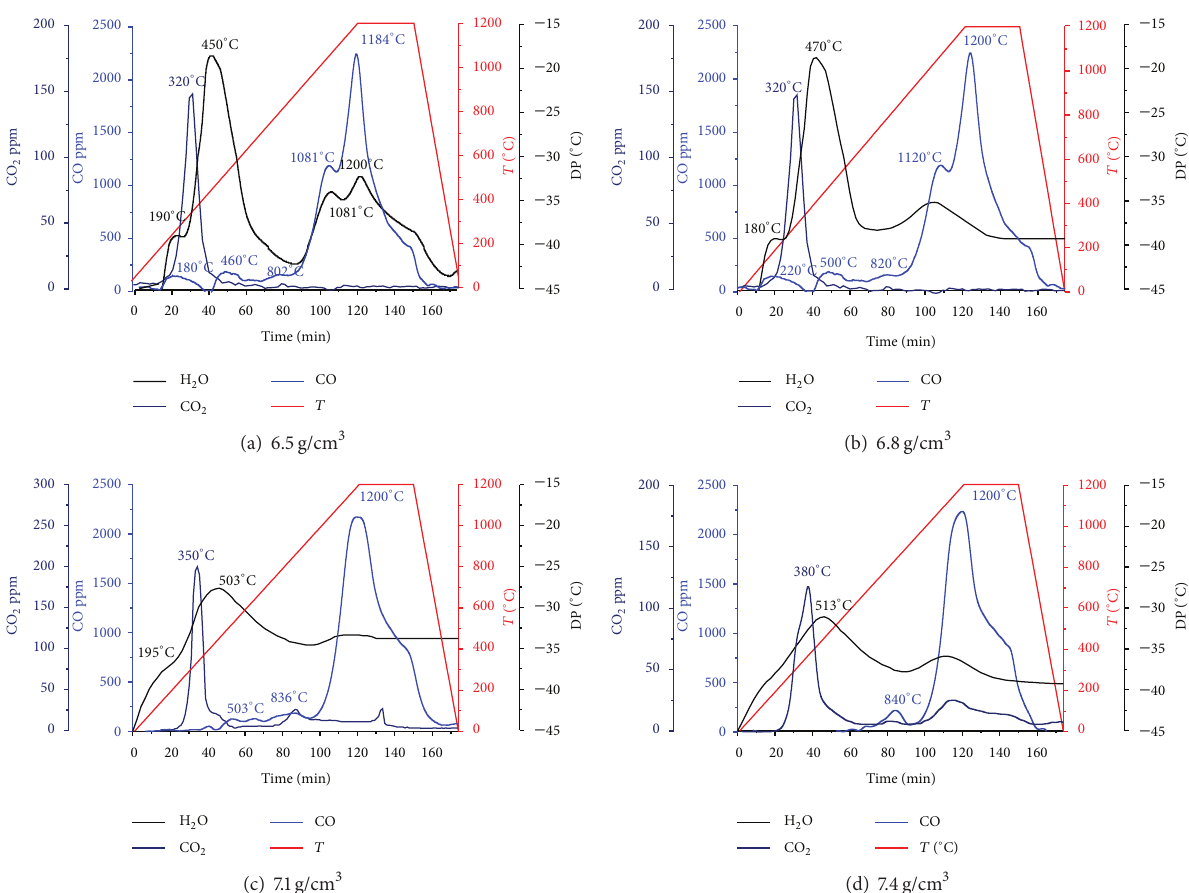
Figure 5: (a)–(d) Spectra of the processing gas composition monitoring during the whole sintering cycle at 1200 ∘ C of the AstCrM + 0.5% C compacts’ densities of 6.5, 6.8, 7.1, and 7.4g/cm 3 ,